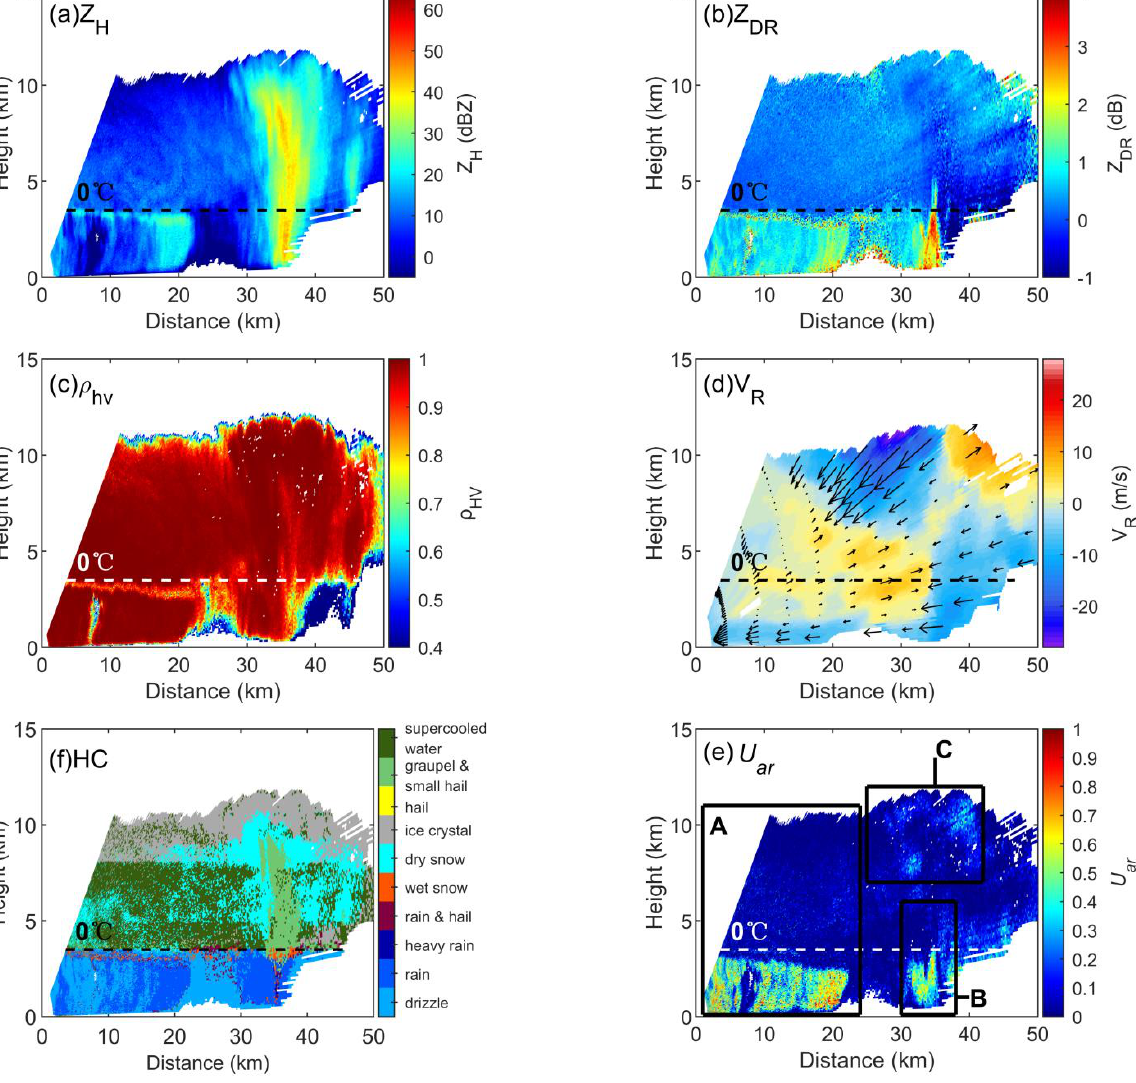
Figure 9. Sample RHI observations and retrievals of the convective system from the X-band dual polarization weather radar. (The time is 18:46:30 LST. The azimuth is the same as the dashed line in Figure 8b. The maximum elevation is 44 ◦ ). ( a ) Z H , ( b ) Z DR , ( c ) ρ hv , ( d ) V R , ( f ) HC, ( e ) U ar